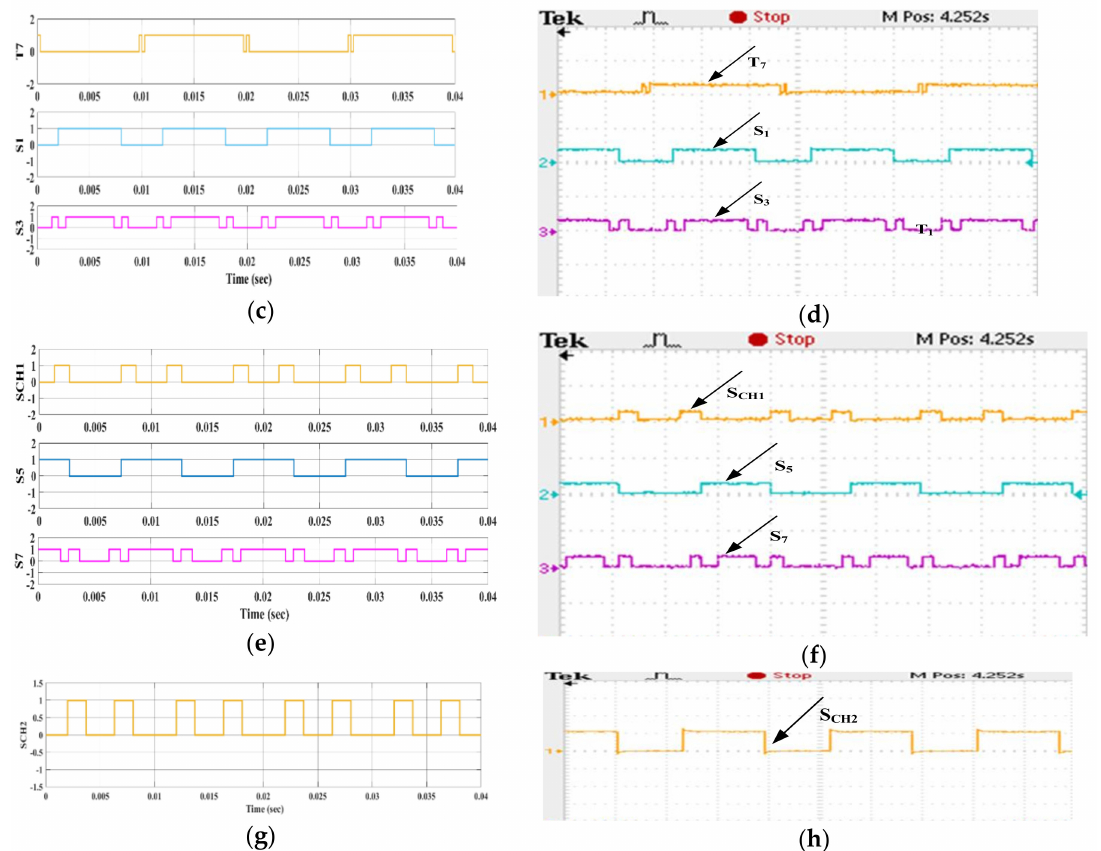
Figure 13. Gating signal of 13 leVel SCMLI: ( a ) and ( b ) Switching pulses for T 1 , T 3 and T 5 (simulated and hardware respectiVely); ( c ) and ( d ) Switching pulses for T 7 , S 1 and S 3 (simulated and hardware respectiVely); ( e ) and ( f ) Switching pulses for SCH 1 , S 5 and S 7 (simulated and hardware respectiVely); ( g ) and ( h ) Switching pulses for SCH 2 (simulated and hardware respectiVely).